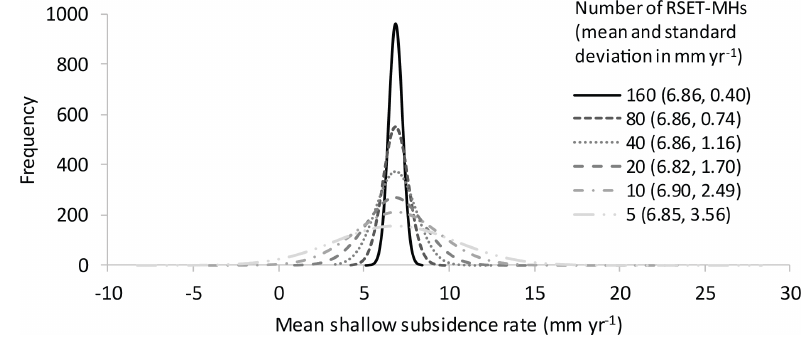
Figure 6. Probability density functions of the mean shallow subsidence rate for a given number of RSET-MHs calculated using a Monte Carlo simulation and 10000 randomizations per